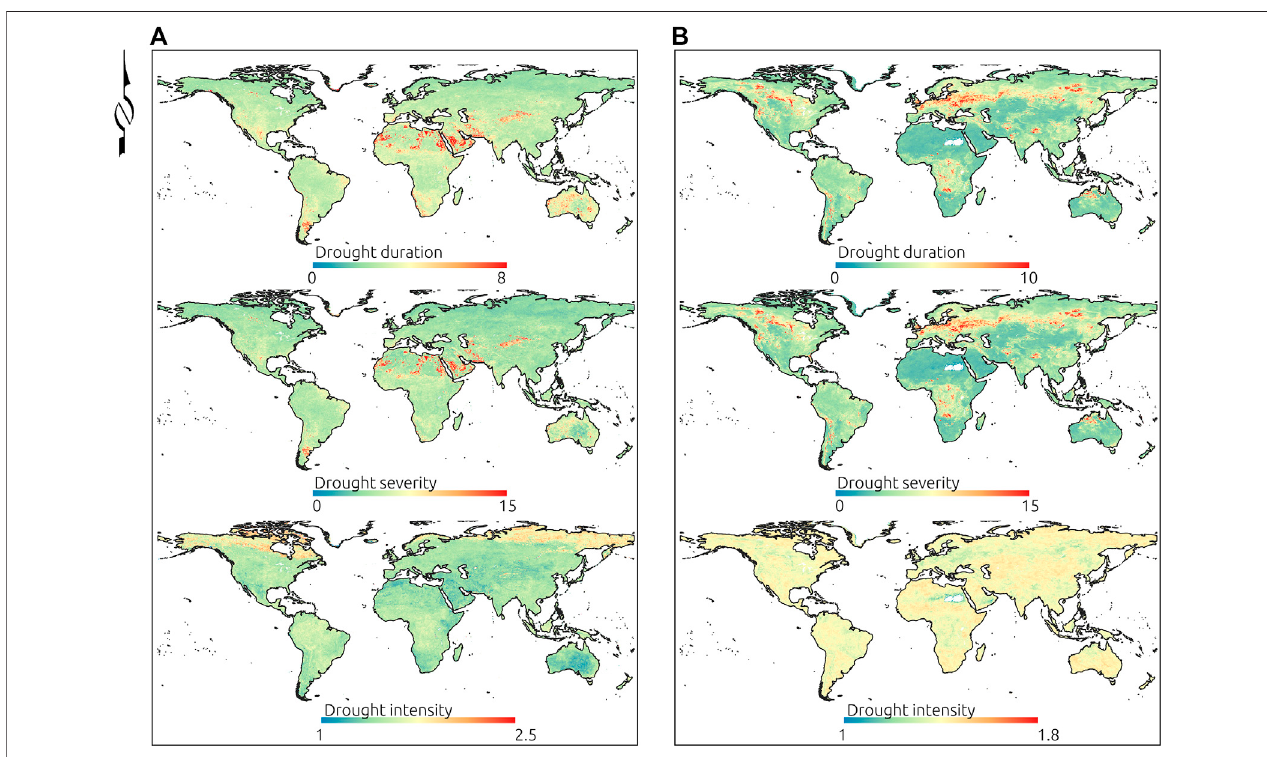
FIGURE 5 | Average 3-month SVI (A) and 3-month SRI (B) drought characteristics.